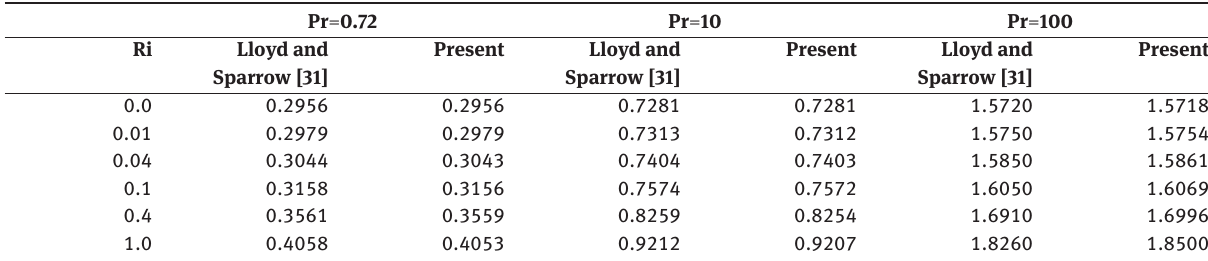
Table 1: Comparison of Nu x Re 1/2 x for mixed convection flow along a vertical flat plate in Newtonian fluid (Lloyd and Sparrow [31]). Pr = 0.72 Pr = 10 Pr = 100 Ri Lloyd and Present Lloyd and Sparrow [31] Sparrow [31]